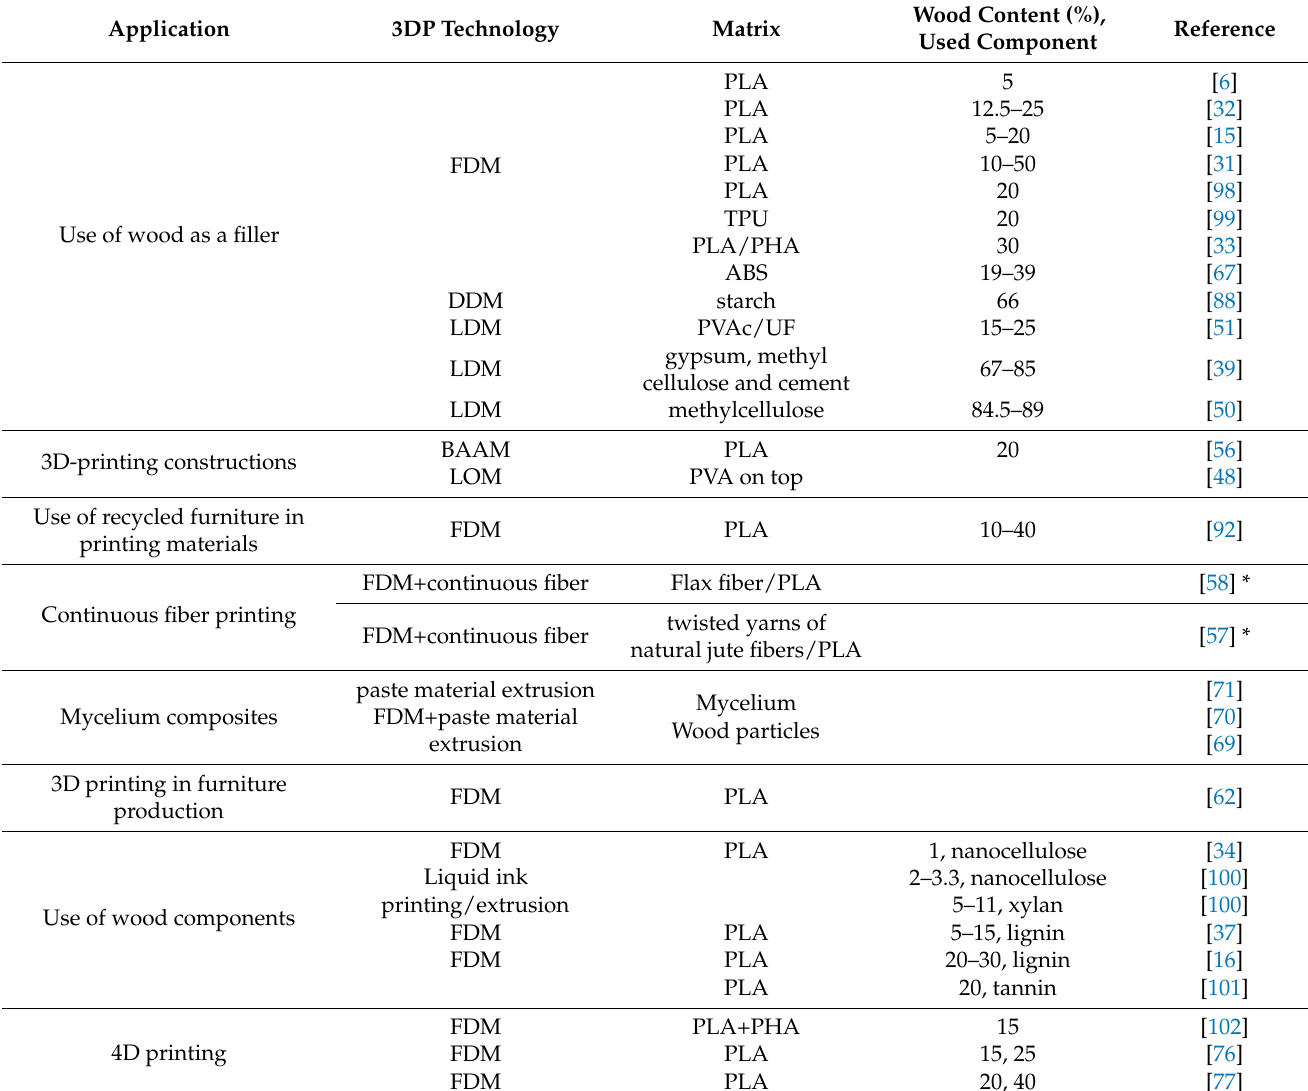
Table 1. Most promising areas of 3D-printing technologies and applications of wood and wood